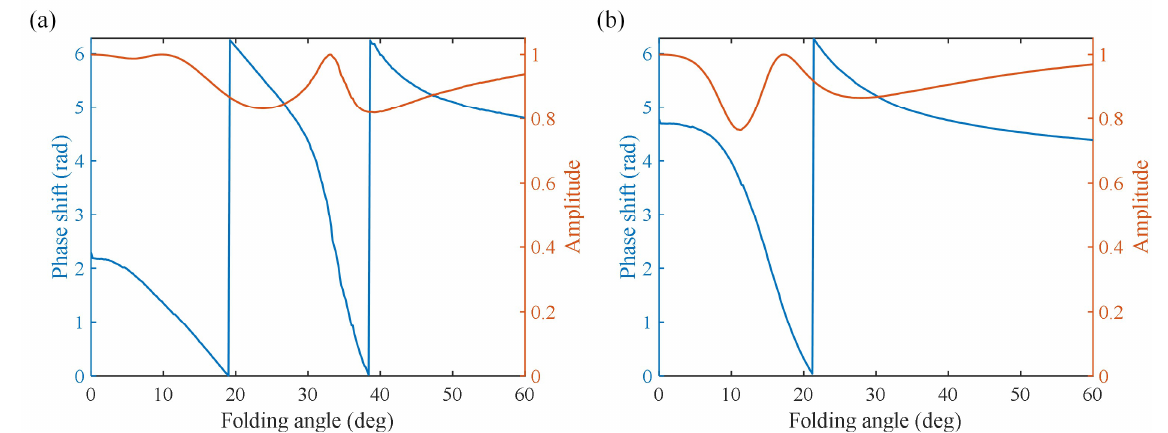
Figure 3. Phase shift and amplitude of the reflected flexural wave for the zig-zag structures with different folding angles at ( a ) 10,000 Hz and ( b ) 12,000 Hz obtained from the numerical simulations.